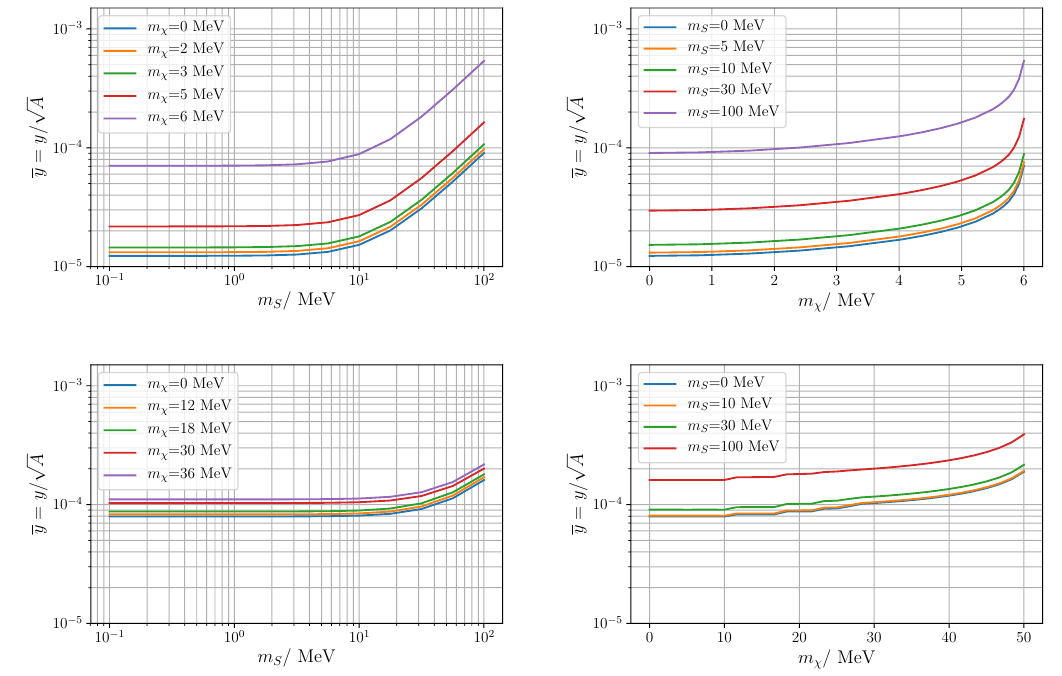
Figure 4 . Constraints (with 90% C.L.) of CONUS (upper panels) and COHERENT (lower panels) in (cid:22) y m S (left panels) and (cid:22) y m (cid:31) (right panels) parameter space. (cid:0) (cid:0) neutrinos, the event rate above 6 MeV is essentially too low to have a signi(cid:12)cant impact and hence the sensitivity to the new physics scenario diminishes. Therefore, the CONUS curves in the right panel rise up quickly around 6 MeV. For COHERENT, the maximal E (cid:23) is about 53 MeV (half of m (cid:22) ) but, unlike in CONUS, the (cid:13)ux is not suppressed when E (cid:23) is approaching 53 MeV, so the curves do not rise so quickly when m (cid:31) is close to the maximal E (cid:23)